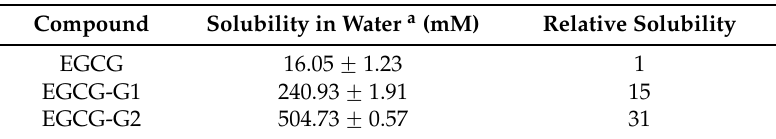
Table 2. Solubilities of EGCG and EGCG